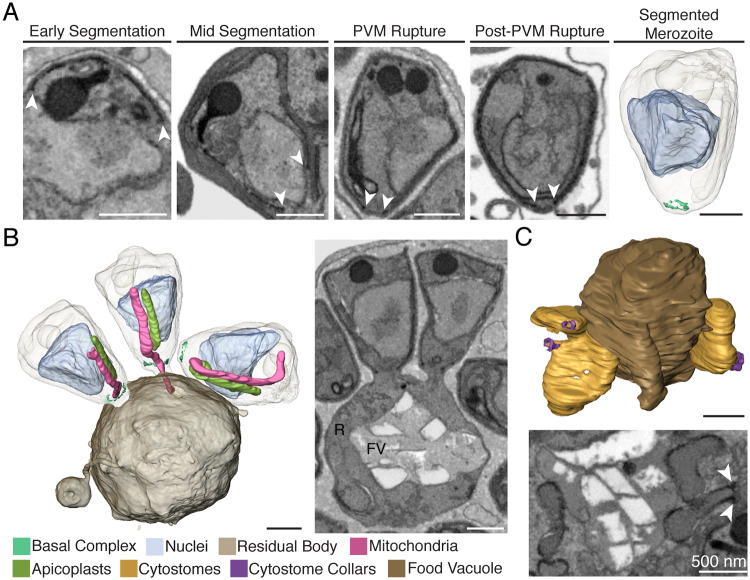
The basal end and food vacuole.A. The basal ring resides at the teardrop shaped basal end of the IMC (white arrows). At PVM rupture, this structure is defined enough to render. B. At PVM rupture, eight merozoites remained attached to the residual body. Two attached and one unattached merozoites are rendered, including one merozoite with its mitochondrion connected to the residual body. R = residual body, FV = food vacuole. C. At mid-segmentation, we visualize the parasite taking up RBC cytosol at cytostomes. These invaginations are located near the food vacuole and their necks are encircled in cytostomal collars, delineated by an electron-dense ring (white arrows). Scale bars of renderings interpolated from structure sizes in EM data.